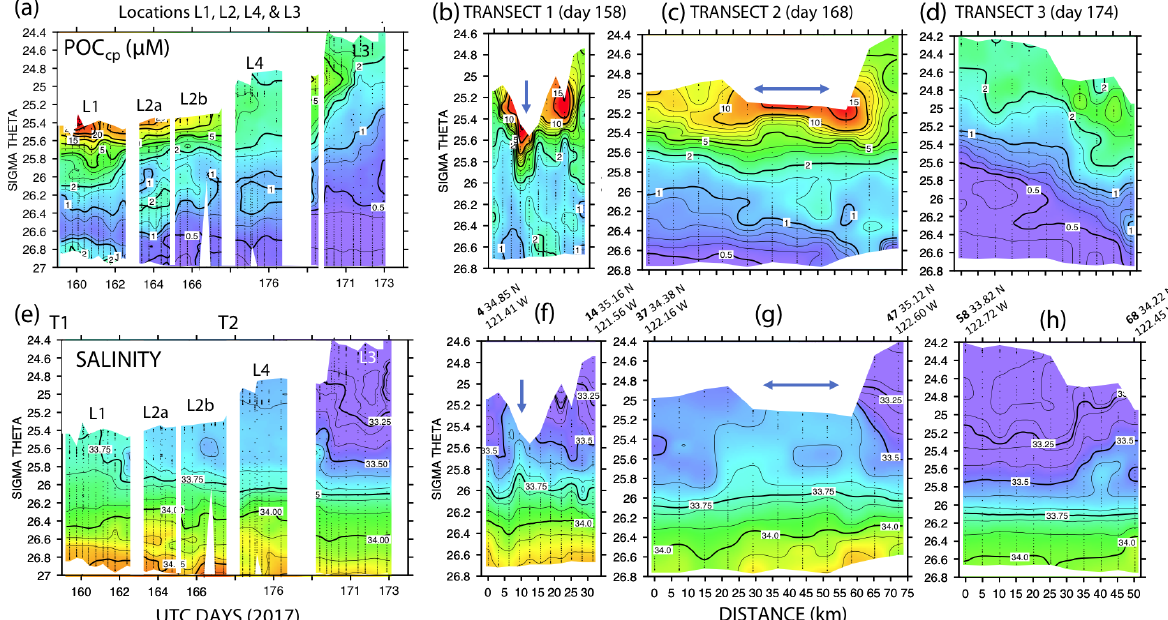
Figure 12. (a) Transmissometer particulate organic carbon (POC) and (e) salinity – potential density time series during the intensive studies at L1, L2a, L2b, L4, and L3. Also shown are cross-filament transects T1, T2, and T3 for POC (b, c, d) and salinity (f, g, h) . Transect locations are shown in Fig. 2. Transect T1 (UTC day 158) was located between L1 and L2; T2 (day 168) was sited between L2 and L4; and T3 crossed the outer edge of the filament on day 174 after completion of work at L4. Distances are in kilometres. UTC days as defined in Fig. 10. The arrows in (f) and (g) indicate the high-salinity surface water in the filament; its scale was ∼ 5km wide at T1 and ∼ 25km wide at